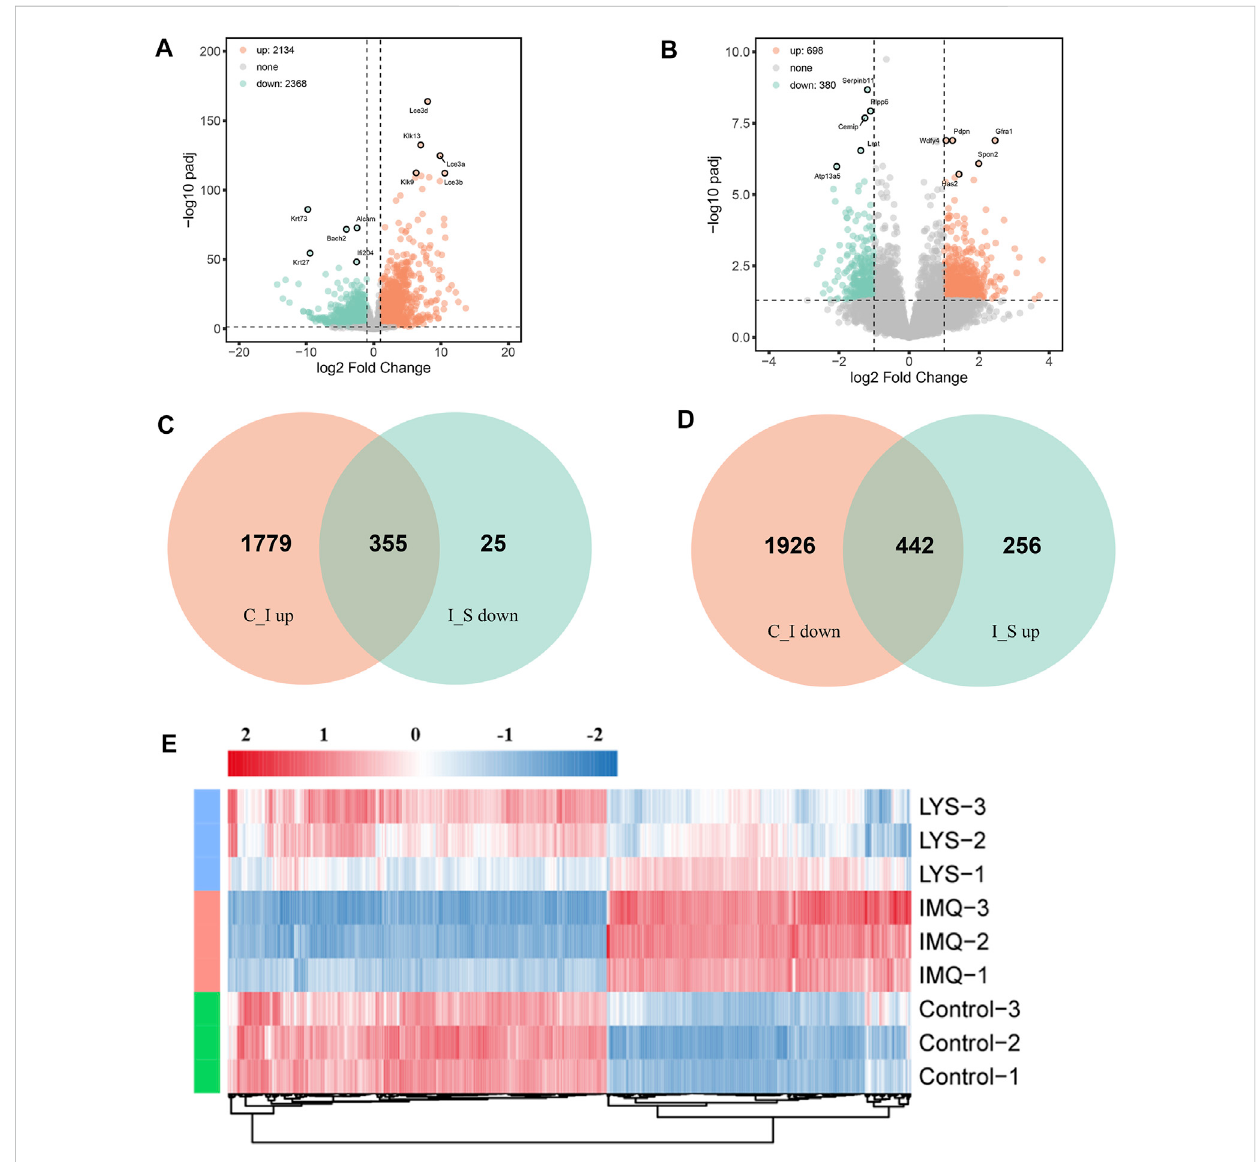
FIGURE 6 DEGs among the control, IMQ and LYS-High groups. (A) Volcano plot of DEGs expressed in the IMQ group compared with the control group. The horizontal axis indicates expression changes (log) of the genes in different treatment groups, while the vertical axis shows the differences in gene expression. The discrepancy was more signi fi cant with smaller p values and higher − log 10 values (adjusted p values). Splashes were for different genes, among which gray dots were for genes with no signi fi cant discrepancy, orange dots were for genes signi fi cantly upregulated, and green dots were for signi fi cantly downregulated genes. (B) Volcano plot of DEGs expressed in the LYS group compared with the IMQ group. (C) Venn diagram showing that the expression of DEGs increased with IMQ treatment and then decreased with LYS treatment. (D) Venn diagram showing that the expression